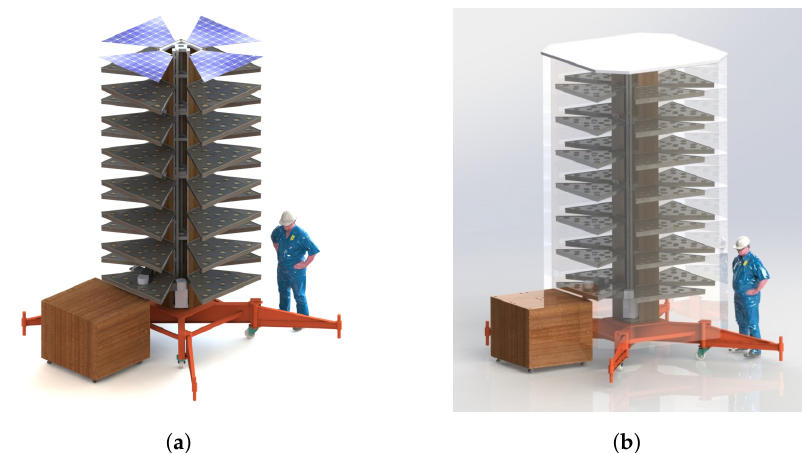
Figure 3. Optional features: ( a ) inclusion of solar panels; ( b ) greenhouse